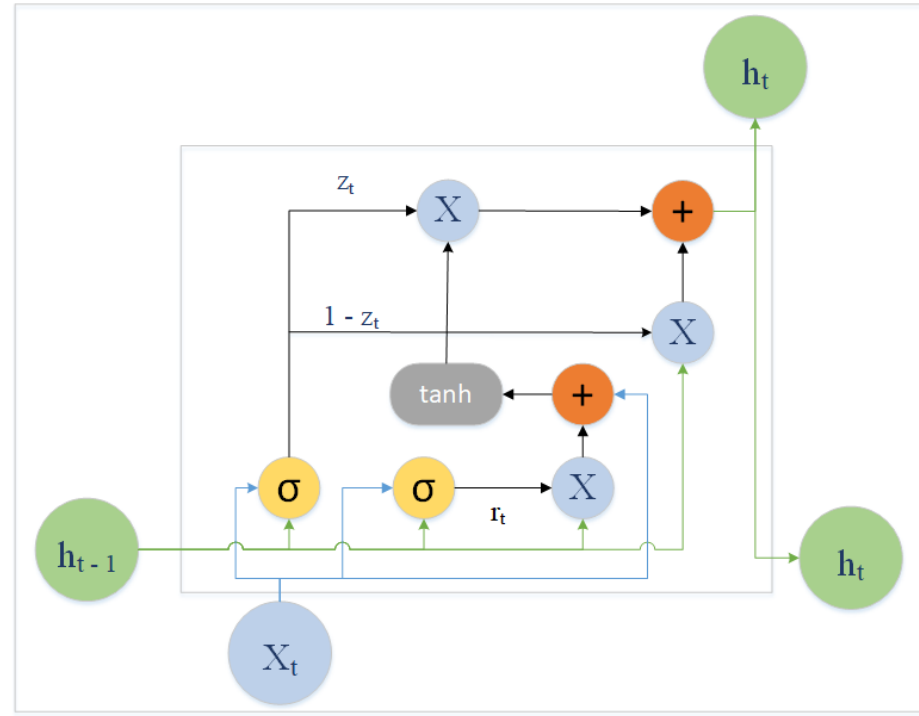
Figure 2. A cell of